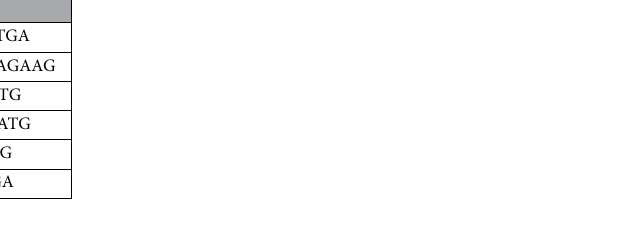
Table 2. List of qPCR